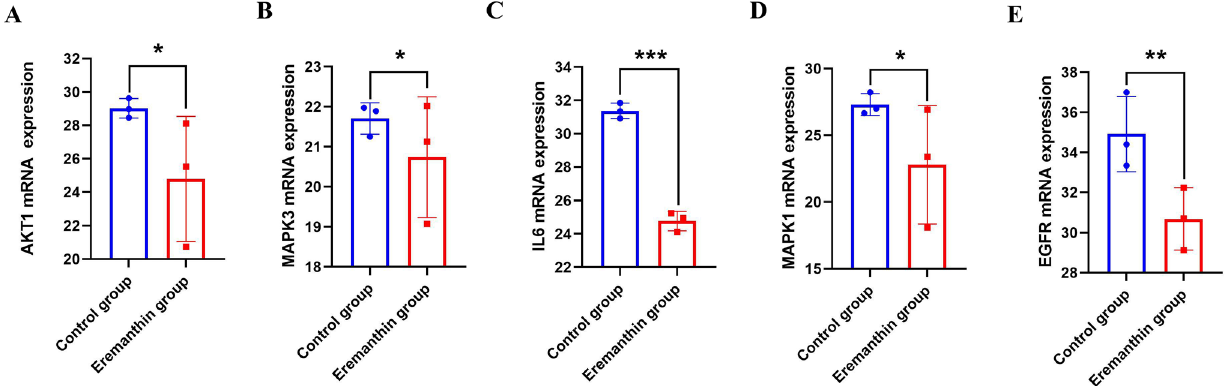
Figure 16. Effect of eremanthin on AKT1, MAPK3, IL6, MAPK1, and EGFR mRNA expression. ( A ) Relative mRNA expression of AKT1, ( B ) relative mRNA expression of MAPK3, ( C ) relative mRNA expression of IL6, ( D ) relative mRNA expression of MAPK1, and ( E ) relative mRNA expression of EGFR (*P < 0.05, **P < 0.01, ***P <